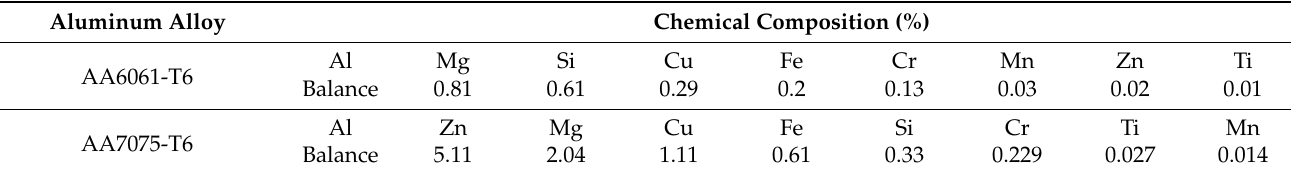
Table 2. Chemical composition of AA6061-T6 and AA7075-T6 Aluminum alloys [36]. Aluminum